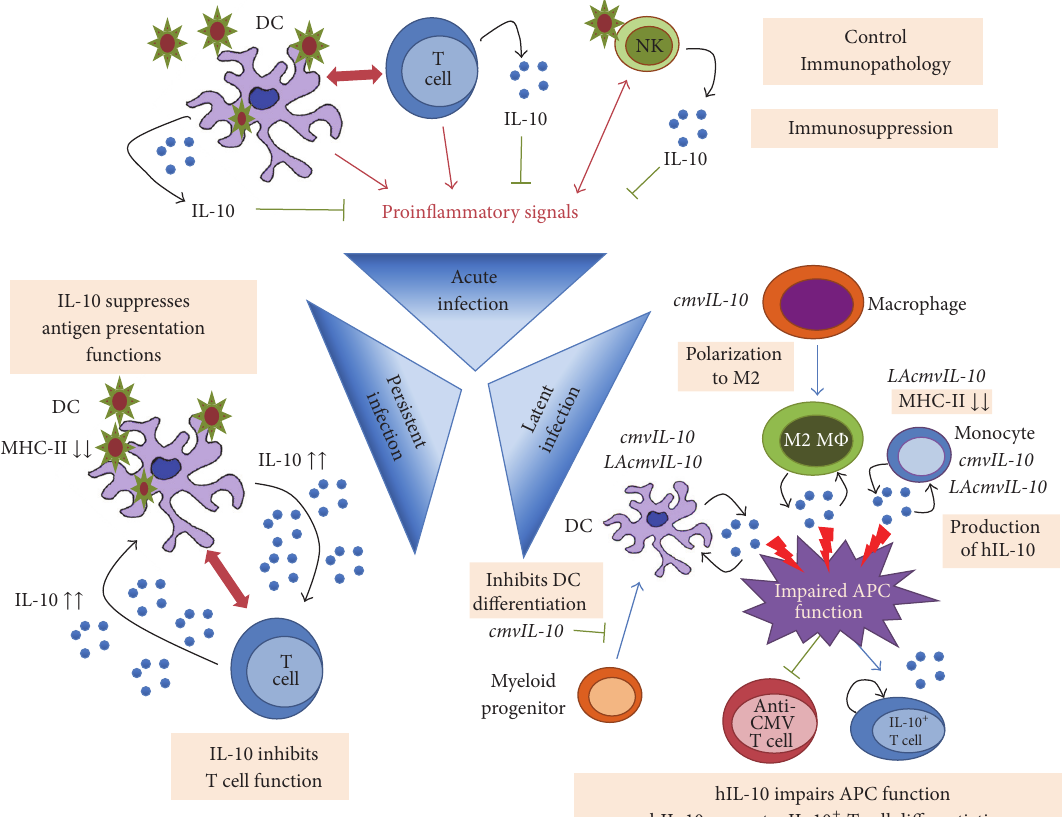
Figure 1: IL-10 role in viral infections. During acute infections, proinflammatory signals are produced by DCs after recognition of pathogen patterns. In parallel, NK cells recognizing pathogen patterns and/or stimulated by proinflammatory signals further enhance inflammation. In this proinflammatory context, DC can promote antiviral T cell responses that clear the infection. Activation of DC, T cells, and NK cells also results in the production of the immunoregulatory cytokine IL-10 to balance inflammation. In this context, IL-10 expression controls immunopathology and leads to the resolution of the inflammation and T cell responses once the pathogen is cleared. During persistent infections, the virus exploits the production of IL-10 by DCs to exhaust antiviral T cells. High IL-10 levels produced by DCs suppress their antigen presenting capacity and lead to inefficient T cell activation. Chronic antigen presence further exhausts T cells and induces IL-10 production. T cells therefore become “tolerant” to viral antigens and infection persists. To establish chronicity and latent infections, the virus produces viral IL-10 homologs that favor anti-inflammatory responses. In human cytomegalovirus infection, cytomegalovirus-encoded IL-10 (cmvIL-10) and latency-associated cytomegalovirus-encoded IL-10 (LAcmvIL-10) are produced in myeloid cells and impair their function. cmvIL-10 induces hIL-10 production in DCs, macrophages, and monocytes, impairs DC differentiation, and promotes M2 polarization of macrophages. LAcmvIL-10 also promotes hIL-10 production in DCs and monocytes and impairs monocyte presenting capacity. IL-10 viral homologs induce human IL-10 (hIL-10) production in myeloid cells that contributes to impairment of their antigen presenting cell (APC) function. This in turn probably limits anti-CMV T cells responses and promotes IL-10 + T cell development. Impaired APC function permits chronic infections, while IL-10 + T cells allow latent infections to